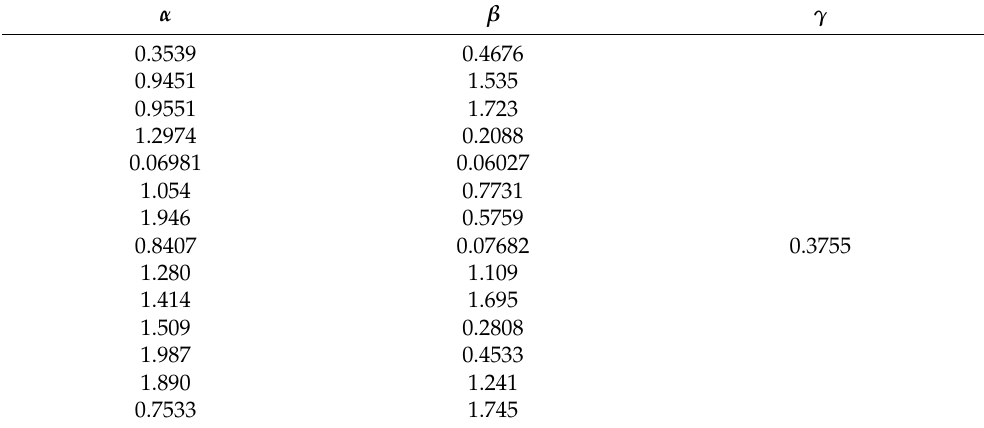
Figure 2. The scattering plots of the first three principal components in the 350.0–700.0 GeV recon- structed energy range. Table 1. The parameters found in the energy range of 350 to 700 GeV by the PCA